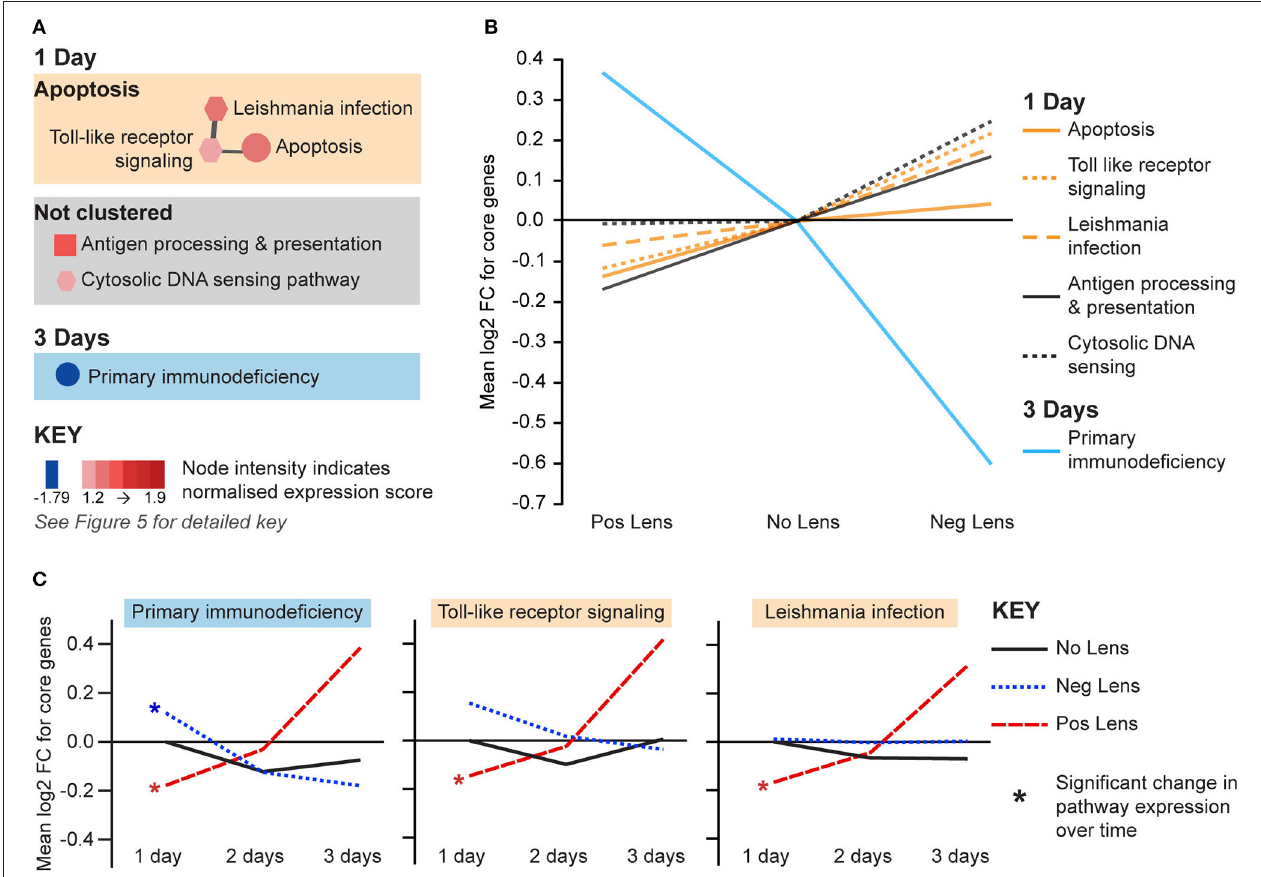
FIGURE 7 | Immune and apoptosis pathway expression changes during refractive compensation. (A) Immune and apoptosis pathways correlated with eye size on days 1 and 3. These pathways are not clustered as the core gene sets responsible for enrichment were unique at each time-point. Node color indicates pathway normalized expression score (NES). Node color indicates the direction of expression change (red = positive correlation with axial length and/or negative correlation with refraction, blue = negative correlation with axial length and/or positive correlation with refraction). Node intensity indicates the normalized expression score (NES) from the axial length analysis (circle and square nodes) or the refraction analysis (polygon nodes). (B) Line graph showing mean log2-fold change for the core genes responsible for each pathways’ enrichment. (C) The primary immunodeficiency pathway from “A” which also showed expression changes across time within positive and negative lens groups. This line graph shows the mean log2-fold change for core genes relative to the 1 day no lens group. Note that because the core genes responsible for pathway enrichment vary for within and across group analyses, these values differ from those shown in “B”. For full details of GSEA results see Supplementary Tables S10,